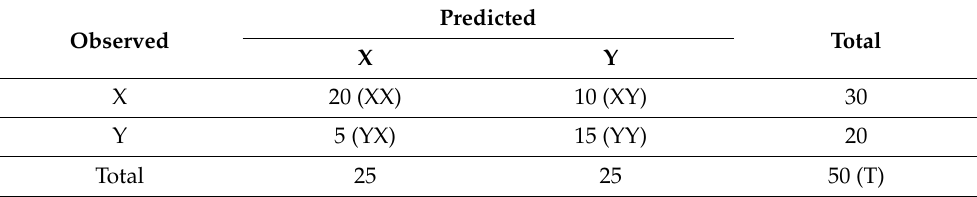
Table 3. A hypothetical scenario calculating comparison parameters of